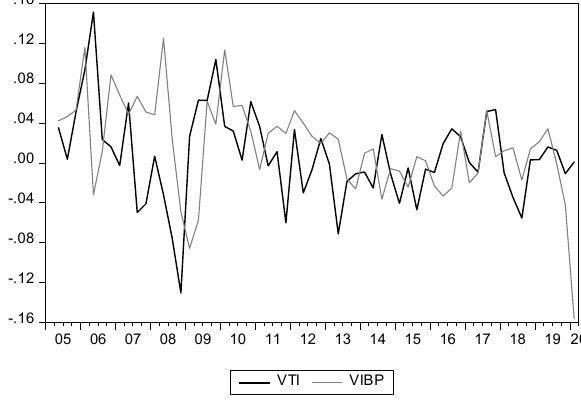
Fig. 2. Var % terms of exchange - Var % private gross investment